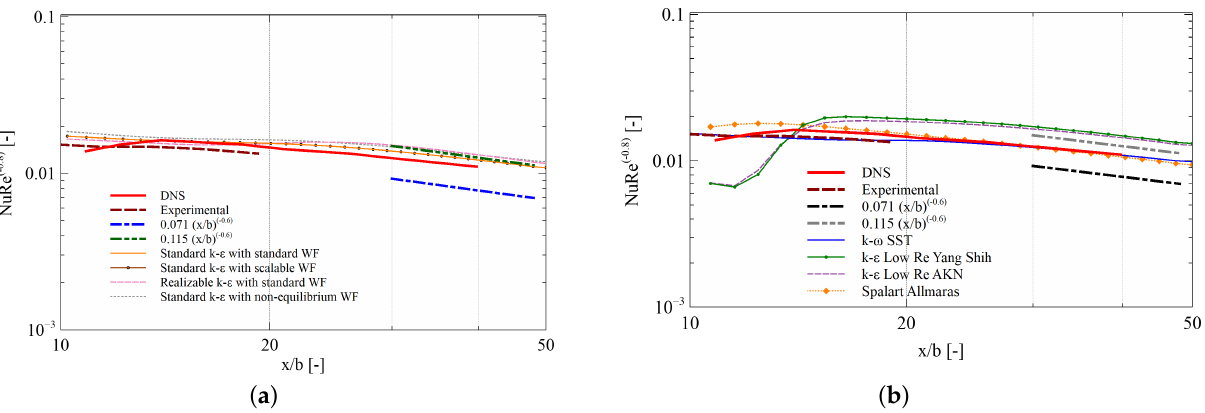
Figure 7. Nusselt number along the wall: ( a ) results of high-Re κ − ε turbulence models with wall functions; and ( b ) results of low-Re